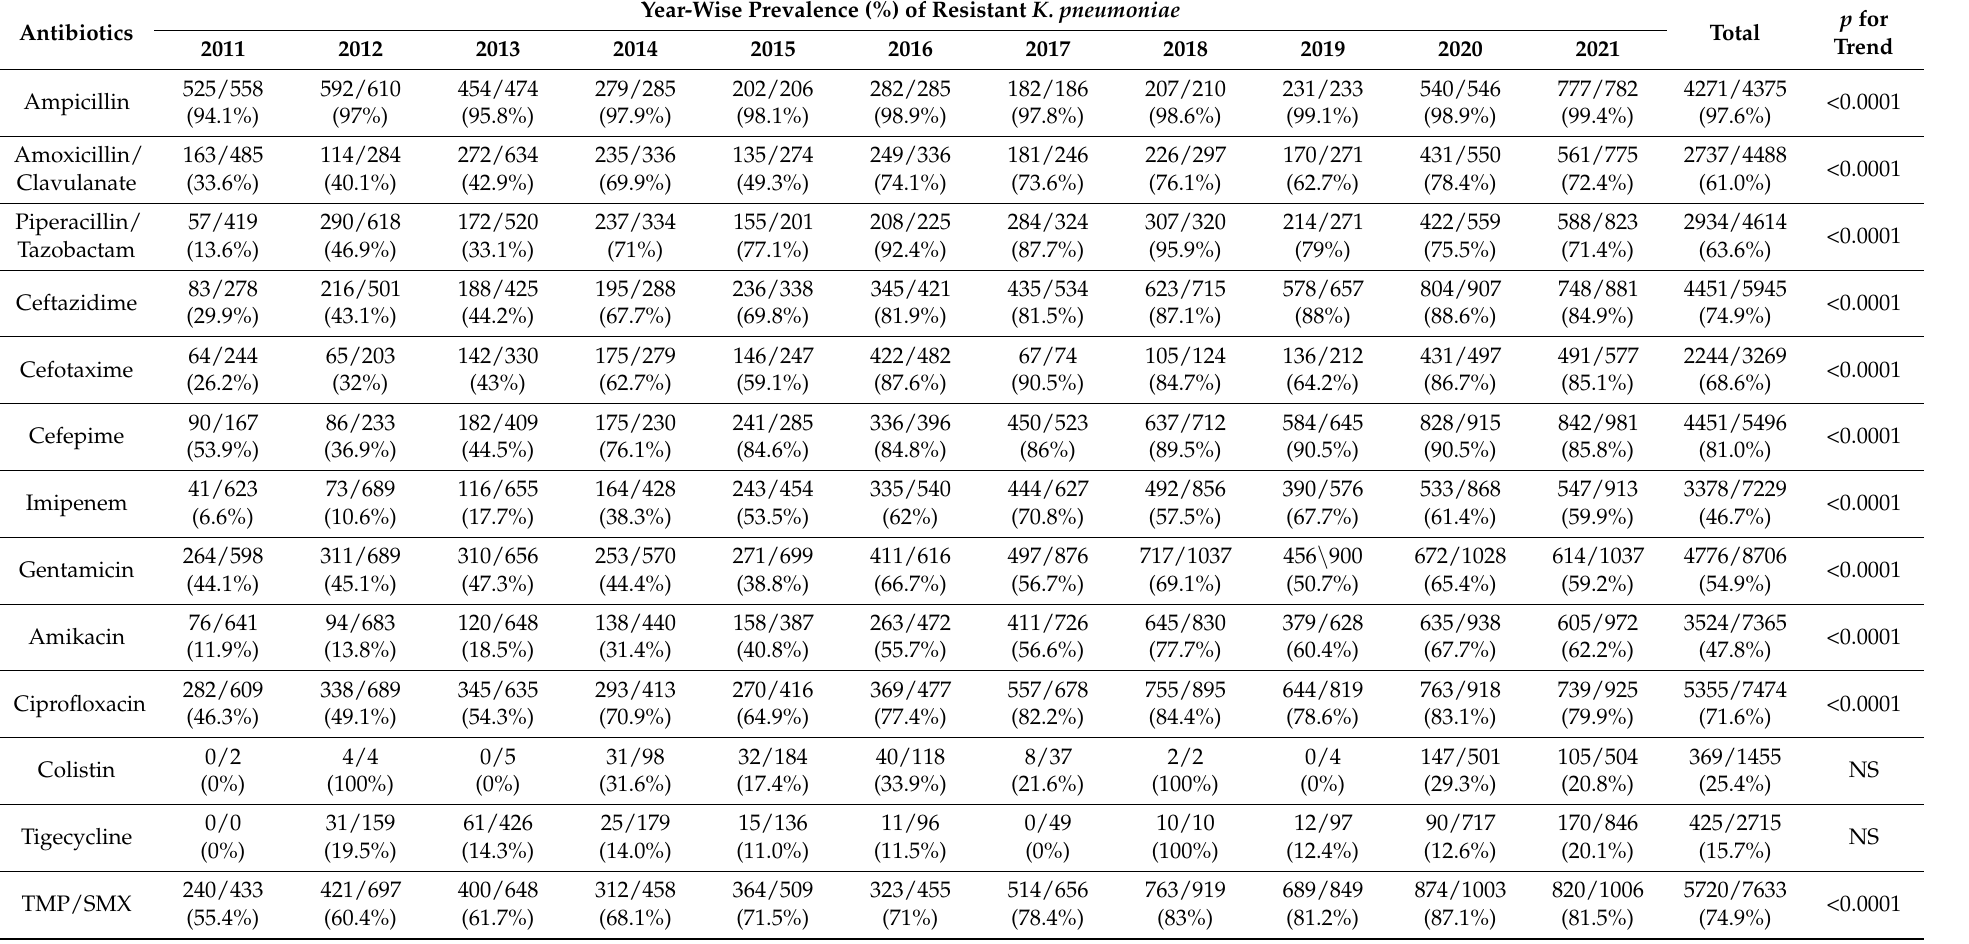
Table 3. Antibiogram pattern of K. pneumoniae